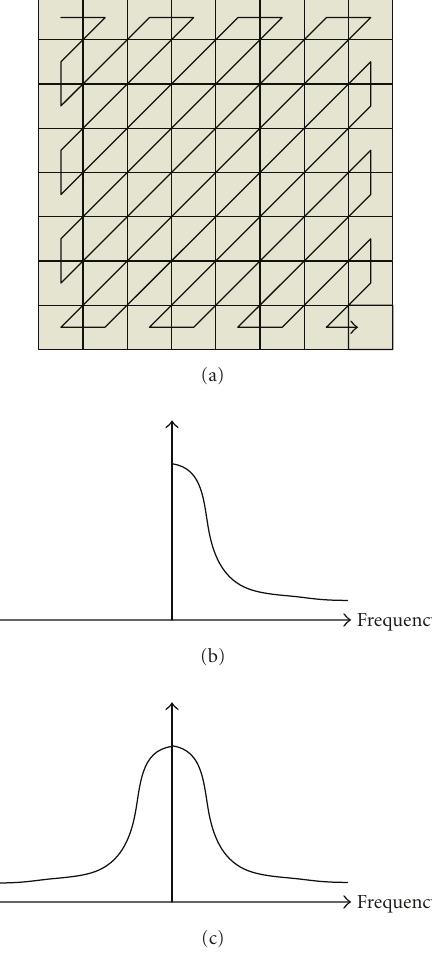
Figure 5: (a) Zigazg scanning for a 8 × 8 block (b) 1D signal distribution after zigzag scanning order. (c) The symmetric type of frequency for the 1D signal